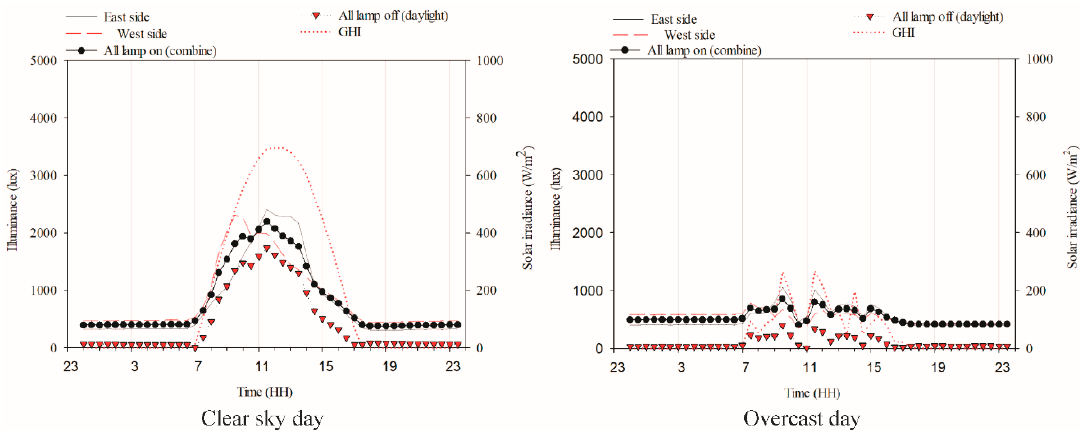
Figure 11. Indoor illuminance response to clear and overcast sky formation.